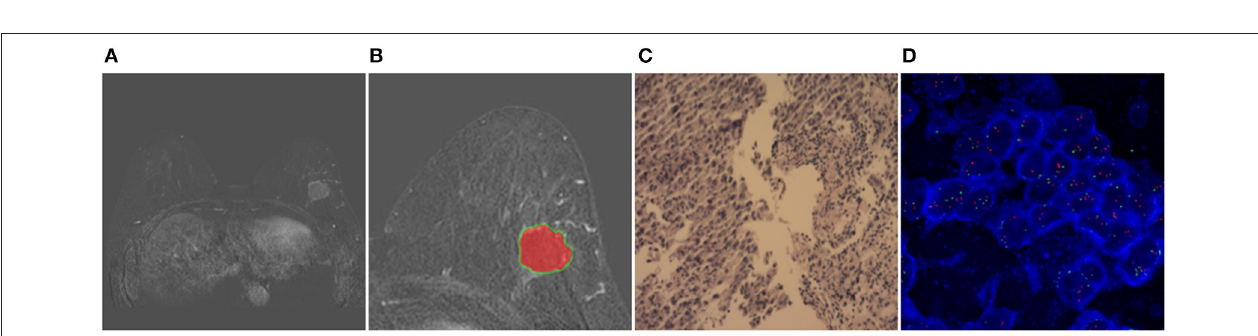
FIGURE 3 | Results obtained from a randomly-selected HER2 2 + positive case. (A) Subtraction image of pre- and post-contrast scans (regular mass and BI-RADS 4C). (B) Enlarged image showing the ROI (red region) delineated manually by an experienced radiologist. (C) Pathology results showing IDCS (HER2 2 + gene confirmed by IHC). (D) Negative HER2 subtype tested by FISH (HER2/CEP17 <